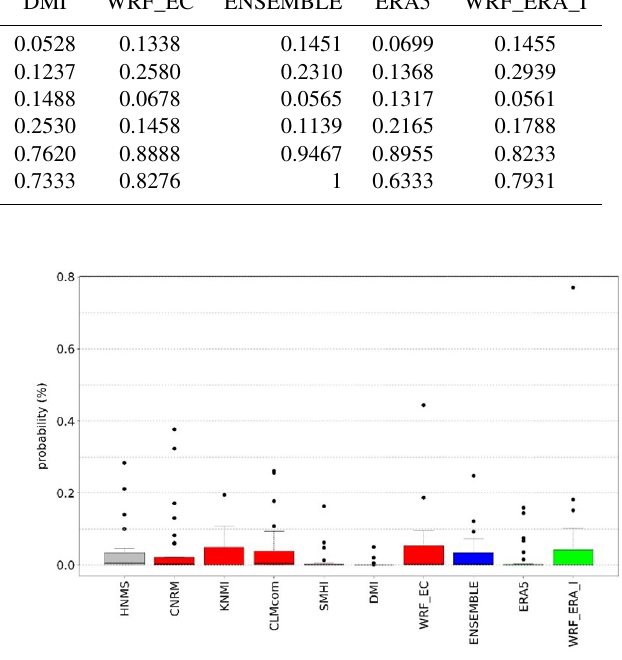
Figure 4. Box plot presenting RR20ID empirical method probabil- ities for observations and models.